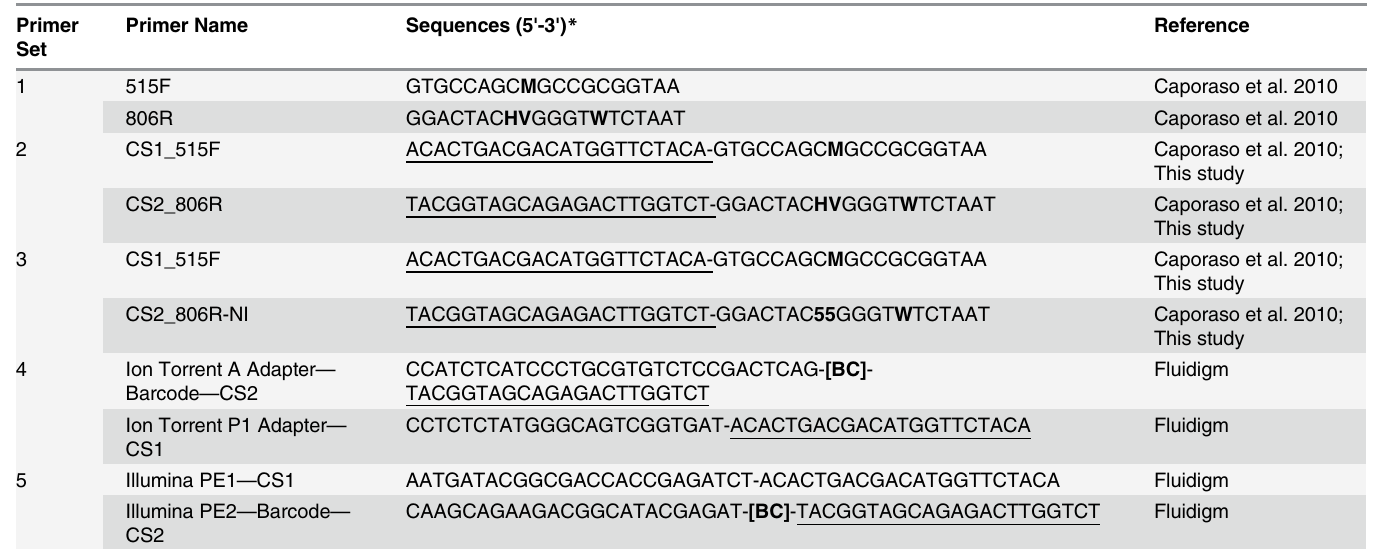
Table 1. Primers used in this